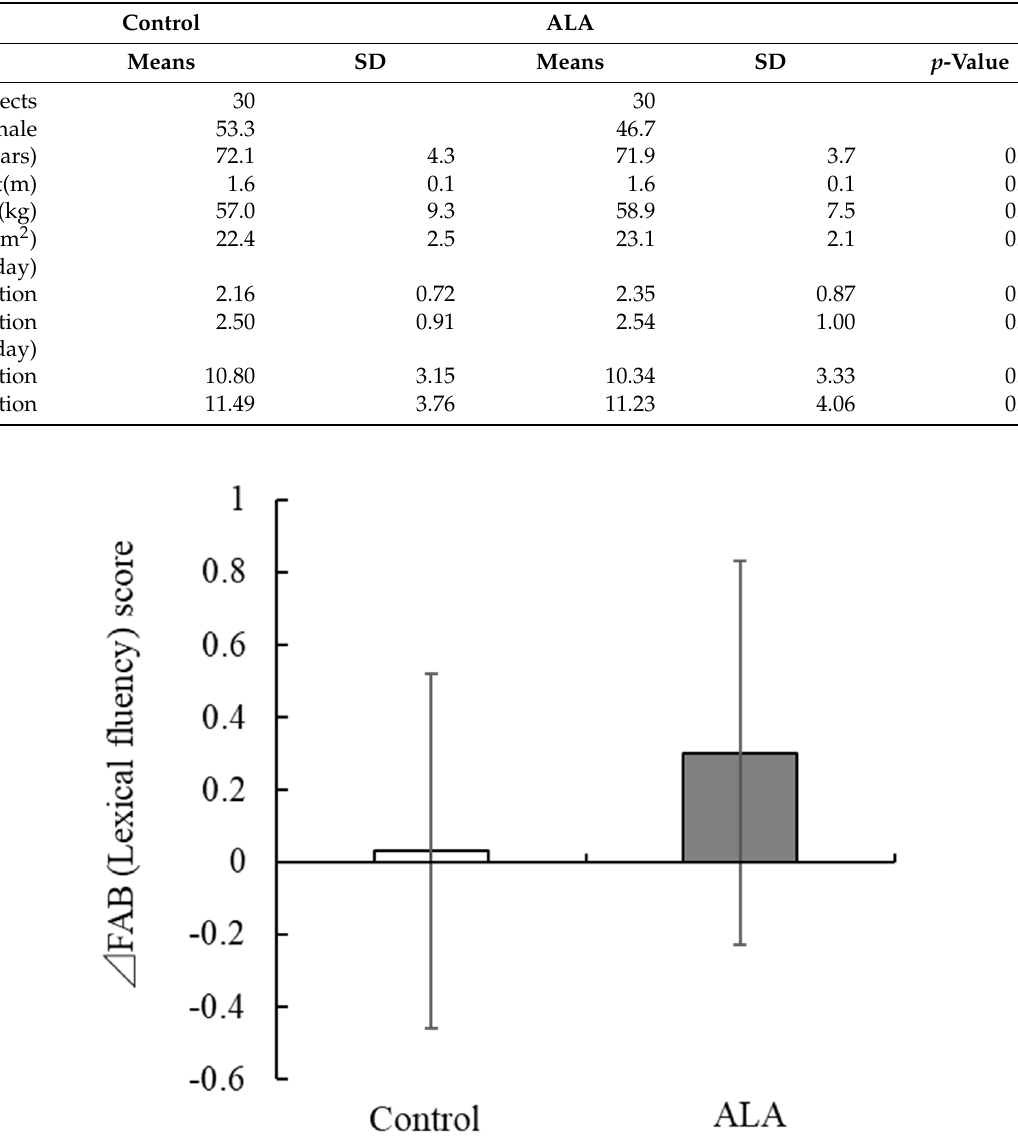
Table 2. Characteristics of the participants.